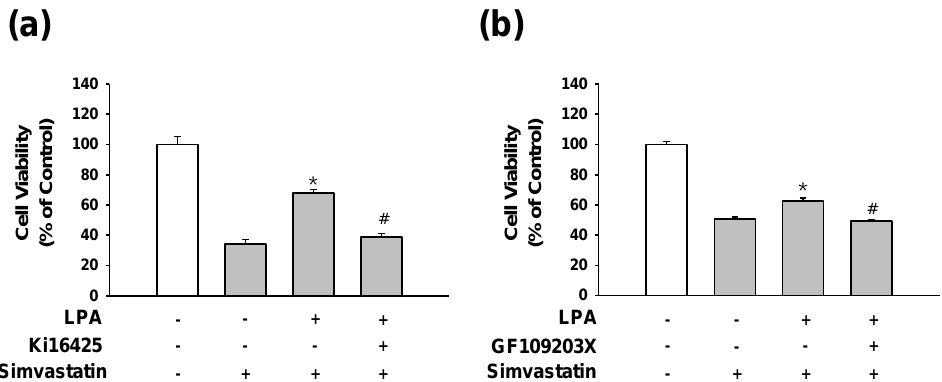
Figure 4. Effects of LPA or PKC inhibition on the viability of LPA-treated L6 cells in the presence of simvastatin. Cells were incubated with or without LPA receptor inhibitor Ki16425 (5 μ M) ( a ), or PKC inhibitor GF109203X (1 μM) ( b ) in the presence of LPA (10 μM) or simvastatin (10 μM) in serum free medium for 48 h. Cell viability was measured using an XTT assay. Levels in the untreated control were considered as 100%. Data represent the means ± SEM (n = 6 for each experiment). * p < 0.05 vs. simvastatin alone; # p < 0.05 vs. LPA with simvastatin.